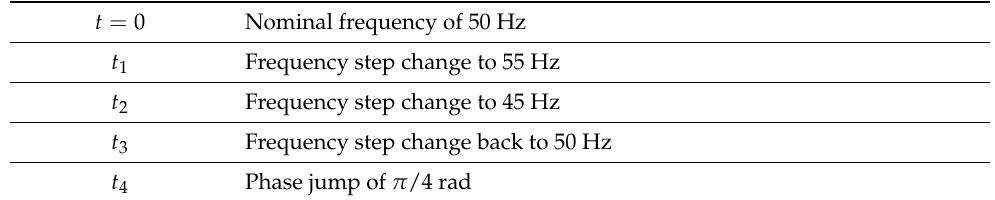
Table 7. Frequency steps and phase jump applied during test